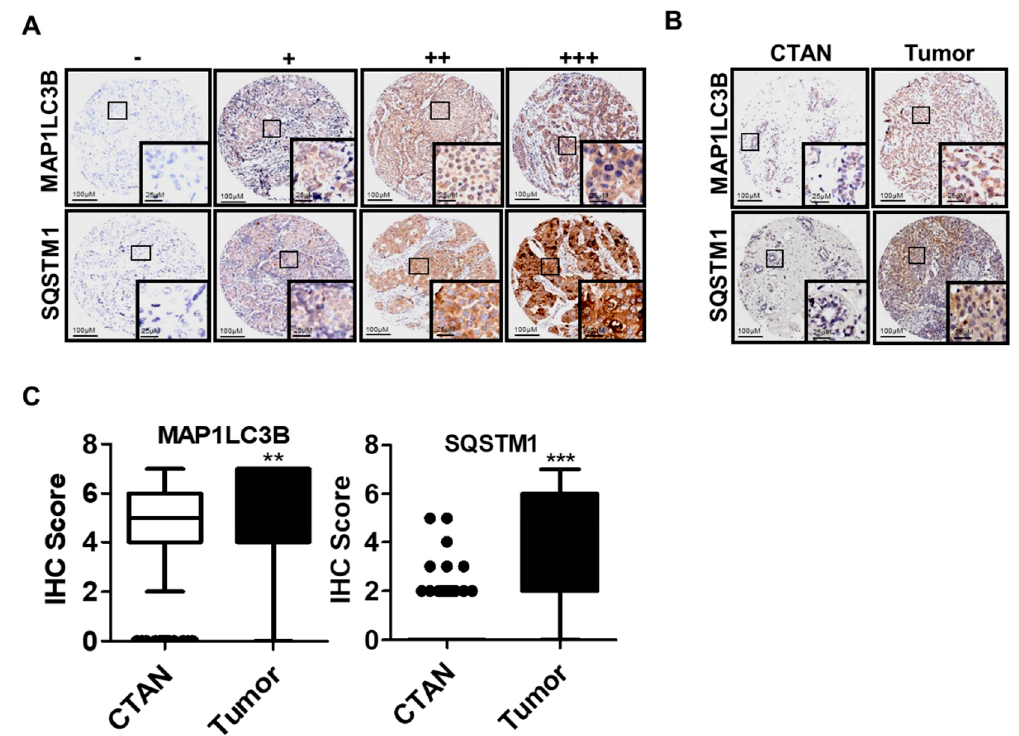
Figure 1. Comparison of MAP1LC3B and SQSTM1 expressions in IDC patients. ( A ) Protein expression of MAP1LC3B and cytoplasmic SQSTM1 were measured by IHC and staining intensity was categorized as − = no expression; + = weak expression; ++ = moderate expression; +++ = strong expression (10 × and 40 × magnification). ( B ) Representative immunoreactivity intensity of MAP1LC3B and SQSTM1 between CTAN and tumor tissues of one paired IDC patients (10 × and 40 × magnification). ( C ) Range of IHC scores of MAP1LC3B and SQSTM1 between CTAN tissues and tumor tissues, respectively, from 91 to 81 paired IDC patients (N: CTAN tissues; T: tumor tissues). ** p < 0.01; *** p < 0.001.